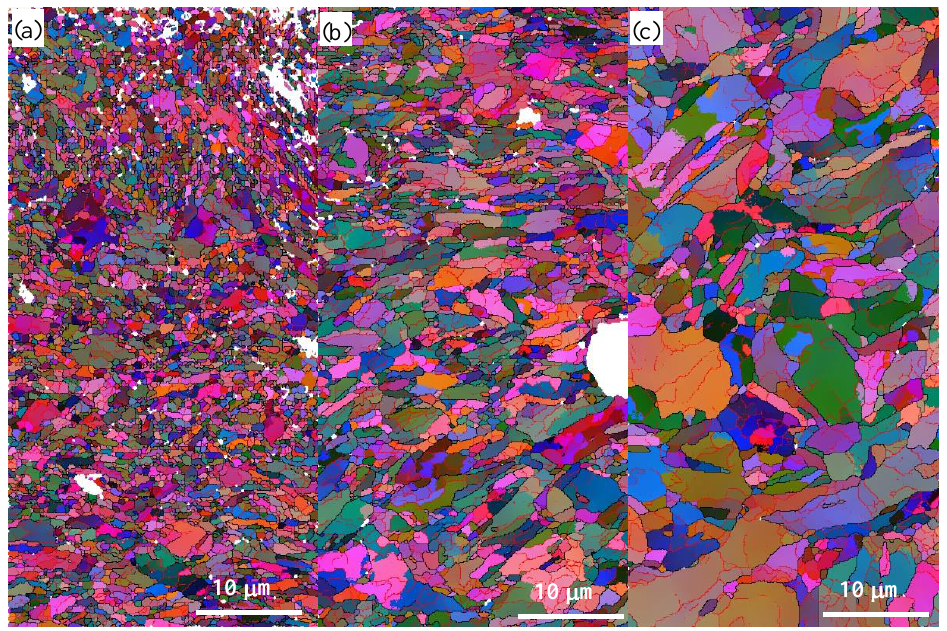
Figure 5. Typical EBSD orientation color maps of the reduced activation steel after SMAT: ( a ) The ultrafine grain zone, ( b ) the transition zone and ( c ) the deformed zone.